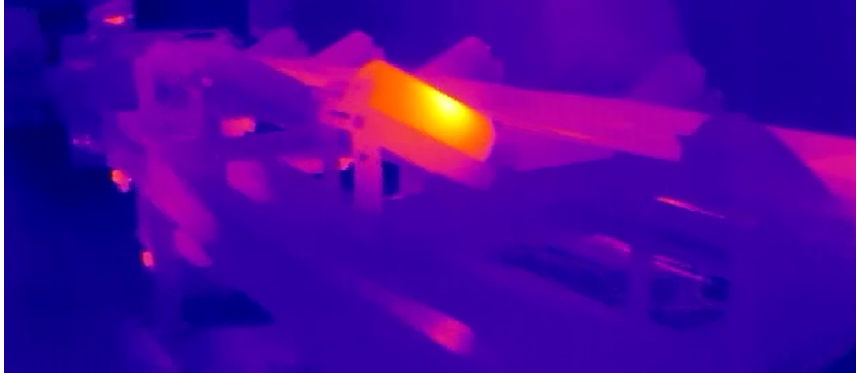
Figure 20. Localized neighbourhood of a